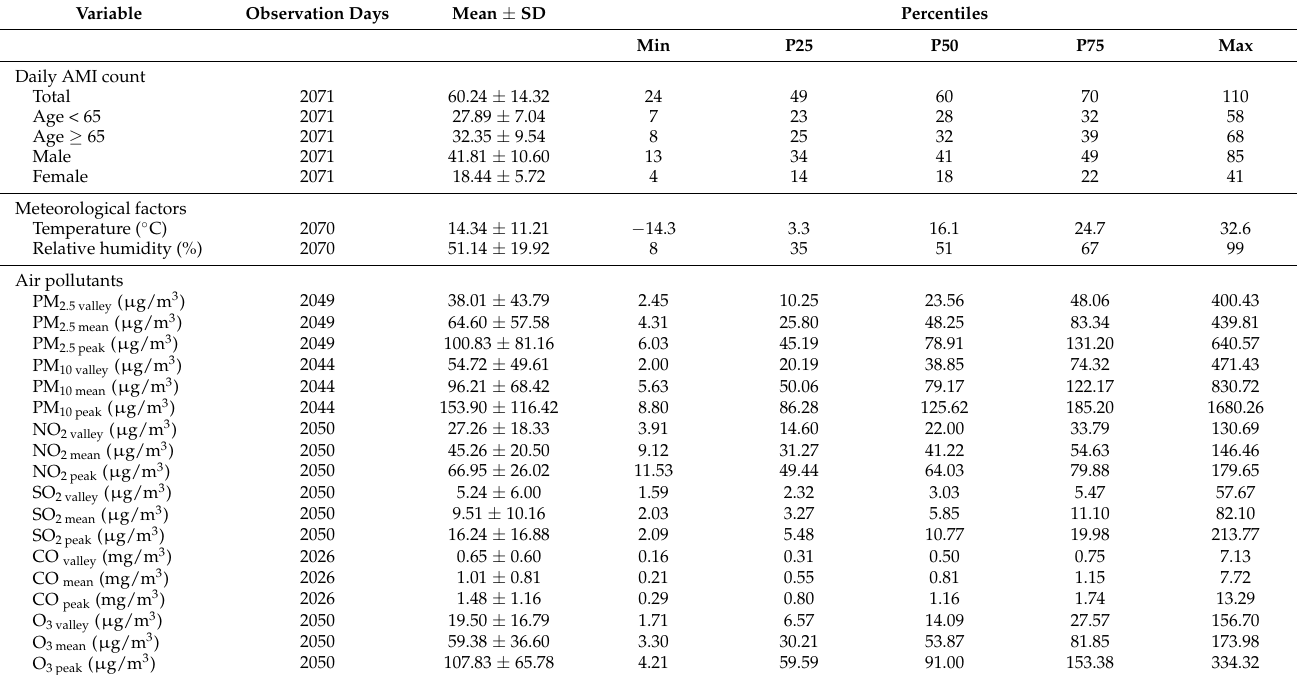
Table 1. The baseline information of the AMI hospital admissions, air pollutants, and meteorological